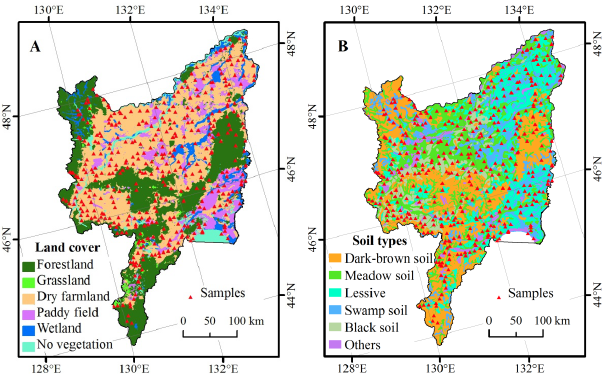
Figure 2. Spatial distribution of field samples, land cover (a) and soil types (b) in the Sanjiang